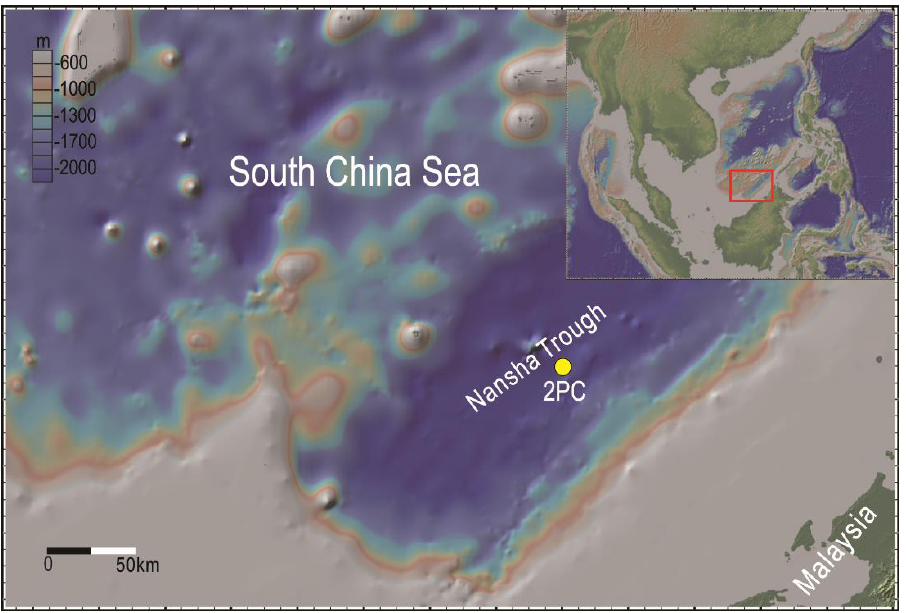
Figure 1. Maps showing the locations of the study area (red rectangle) and sediment core 2PC (yellow dot) in the southern South China Sea (SCS).